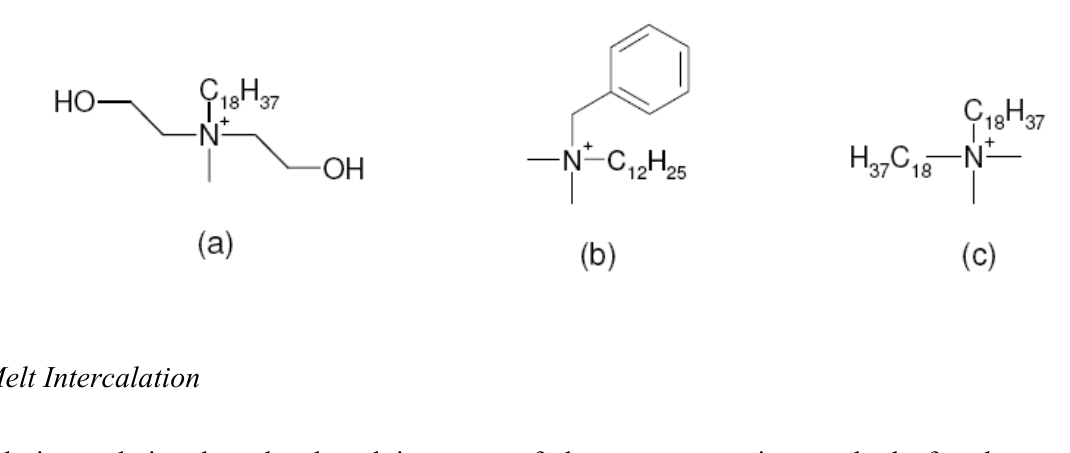
Figure 22. Chemical structures of the modifications exchanges on the filler surface for the generation of polyurethane nanocomposites